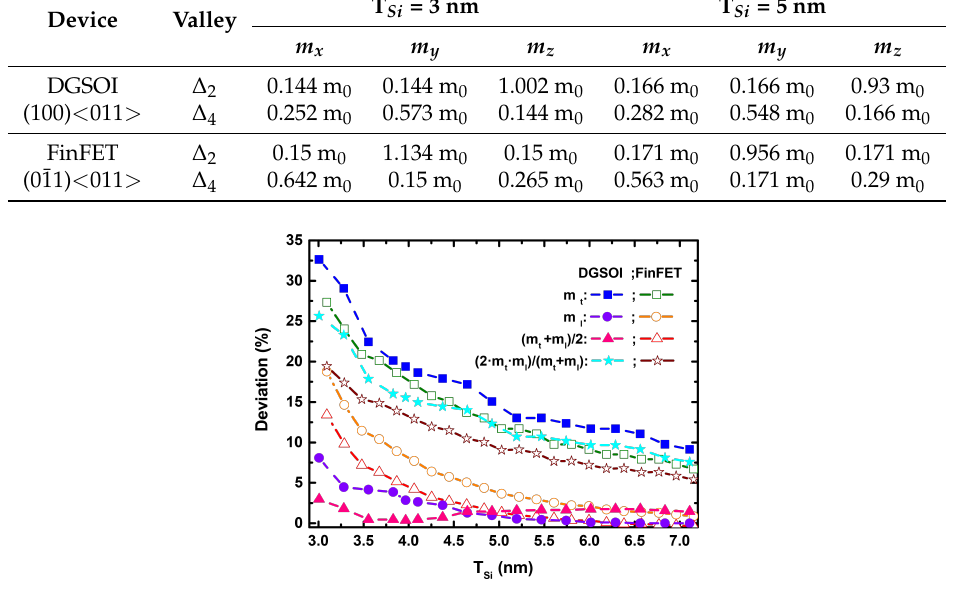
Figure 3. Deviation (%) of the longitudinal ( m l ) and transverse ( m t ) effective masses and their combinations needed in Table 2 as a function of the silicon thickness (T Si ) for DGSOI ((100) confinement orientation) as well as FinFET ((0¯11) confinement orientation)